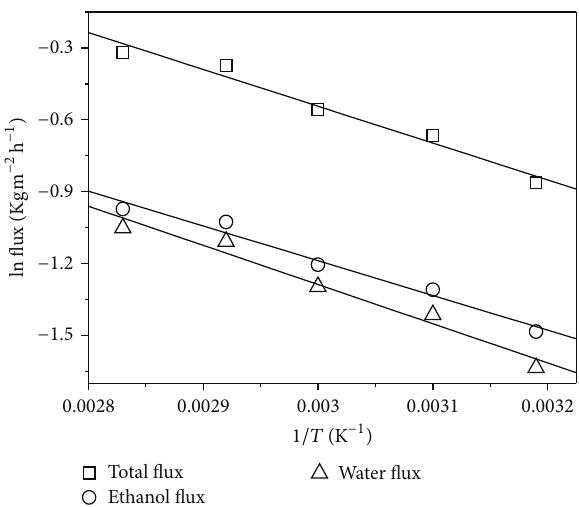
Figure 9: Arrhenius plots of the PDMS-VTOS